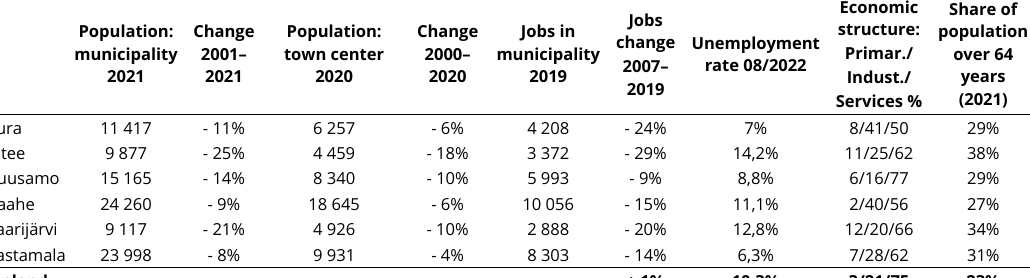
Table 1. The six towns’ socio-economic characteristics and development in a nutshell (Source: Tilastokeskus 2022; TEM 2022).